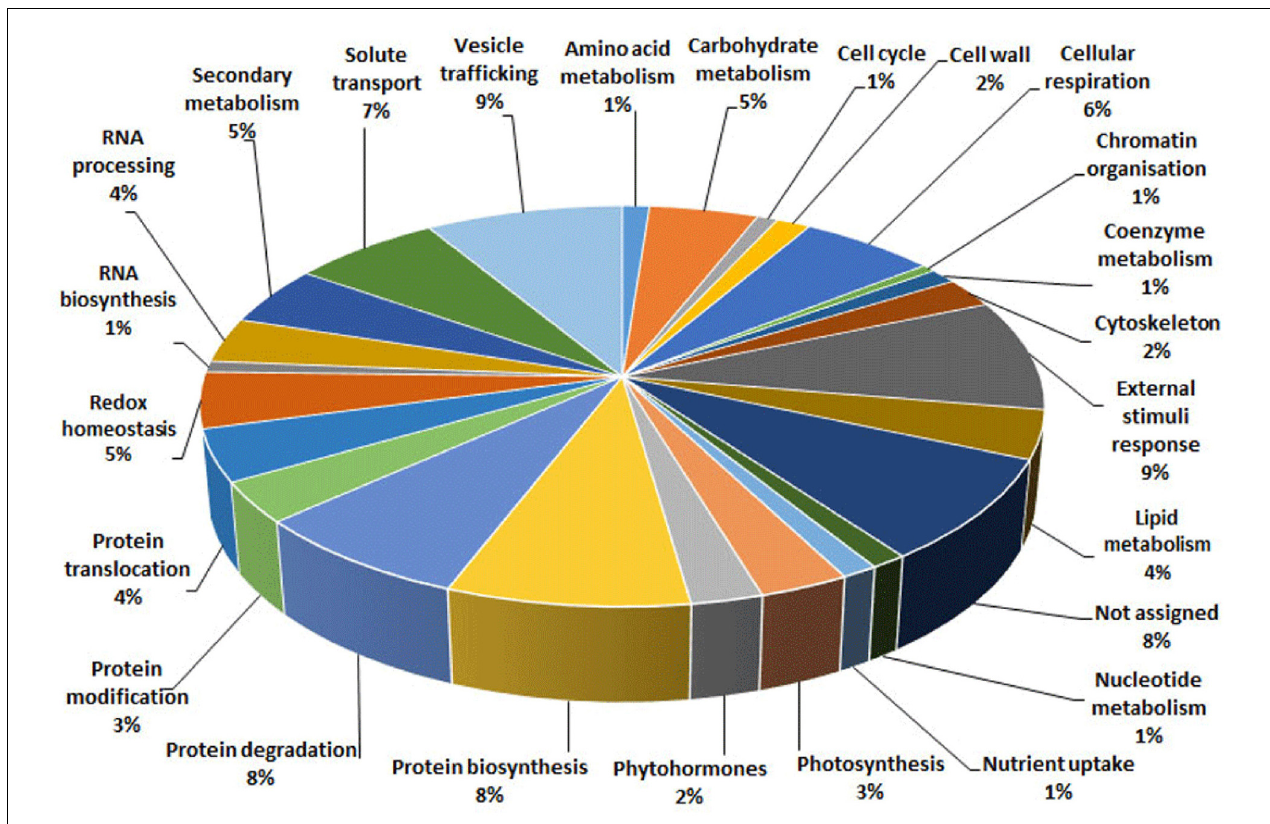
FIGURE 3 | Functional distribution of differentially represented proteins present in strawberry fruits produced by plants subjected to the treatment with Trichoderma strains (T22, TH1, and GV41), as compared to control (CTR). Identified protein species were initially assigned with Mercator software ( Supplementary Table S3 ), followed by a functional group cataloguing including information from the Bevan classification (Bevan et al., 1998) and recent literature